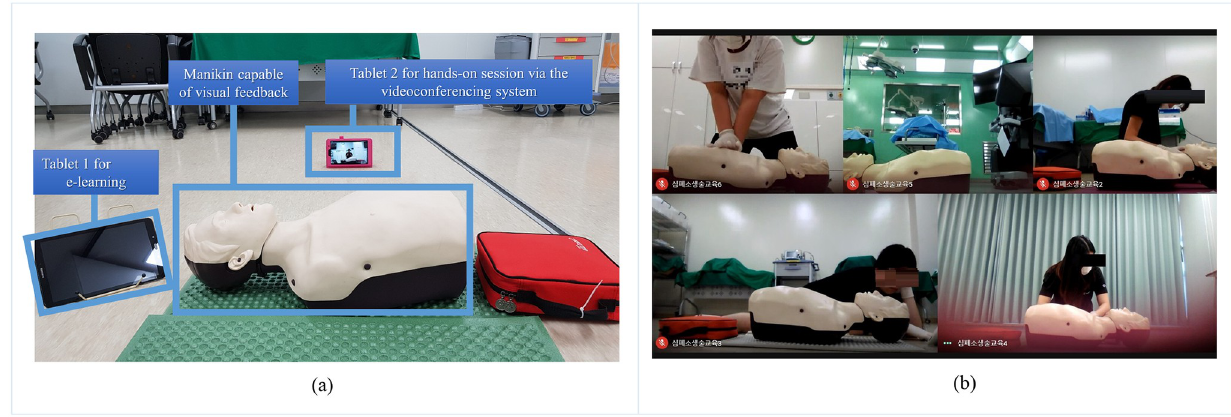
Fig 2. Environmental setting for the distance learning simulation (a) and videoconferencing system setting for the distance hands-on session (b).